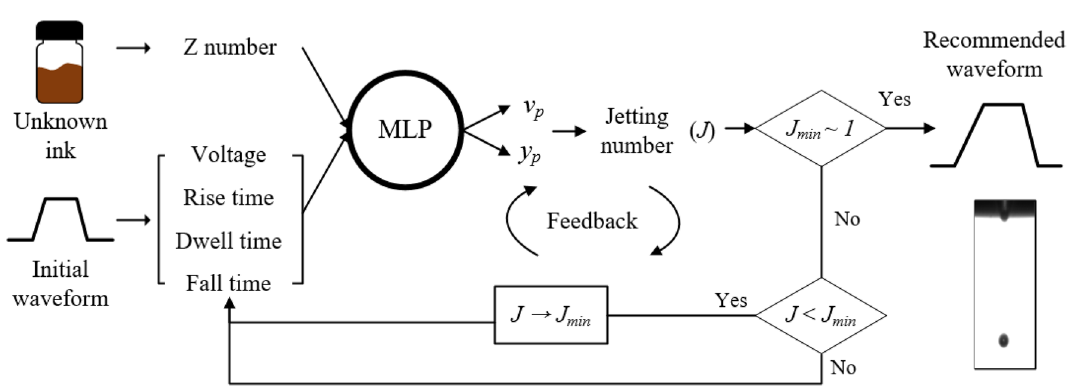
Figure 5. Schematic diagram of a waveform recommendation